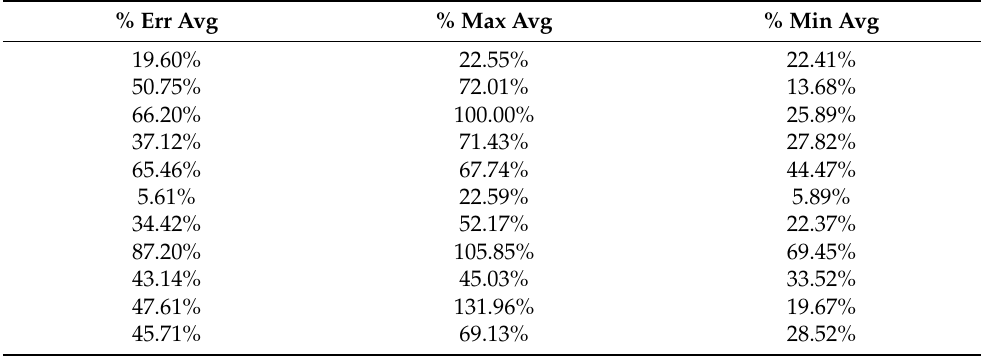
Table A133. Set 2, trials 31–40 data (single 0.5 PR